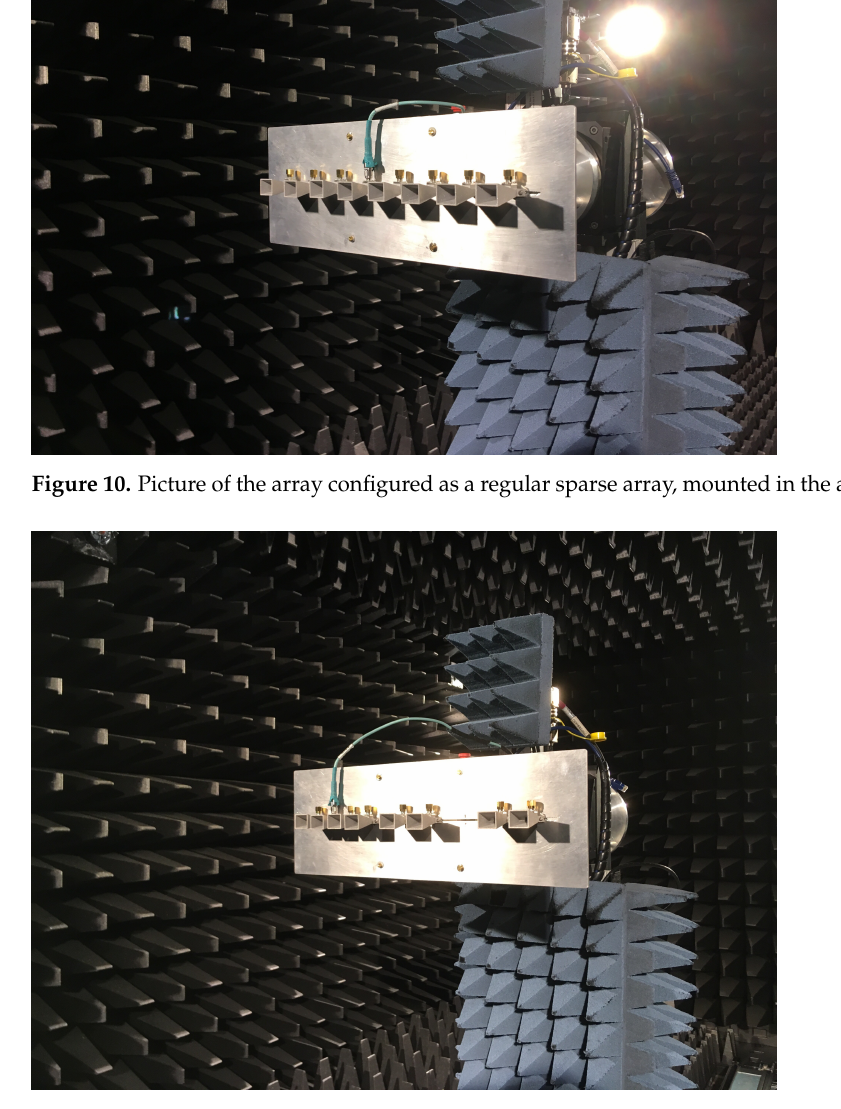
Figure 11. Picture of the array configured as an irregular sparse array, mounted in the anechoic